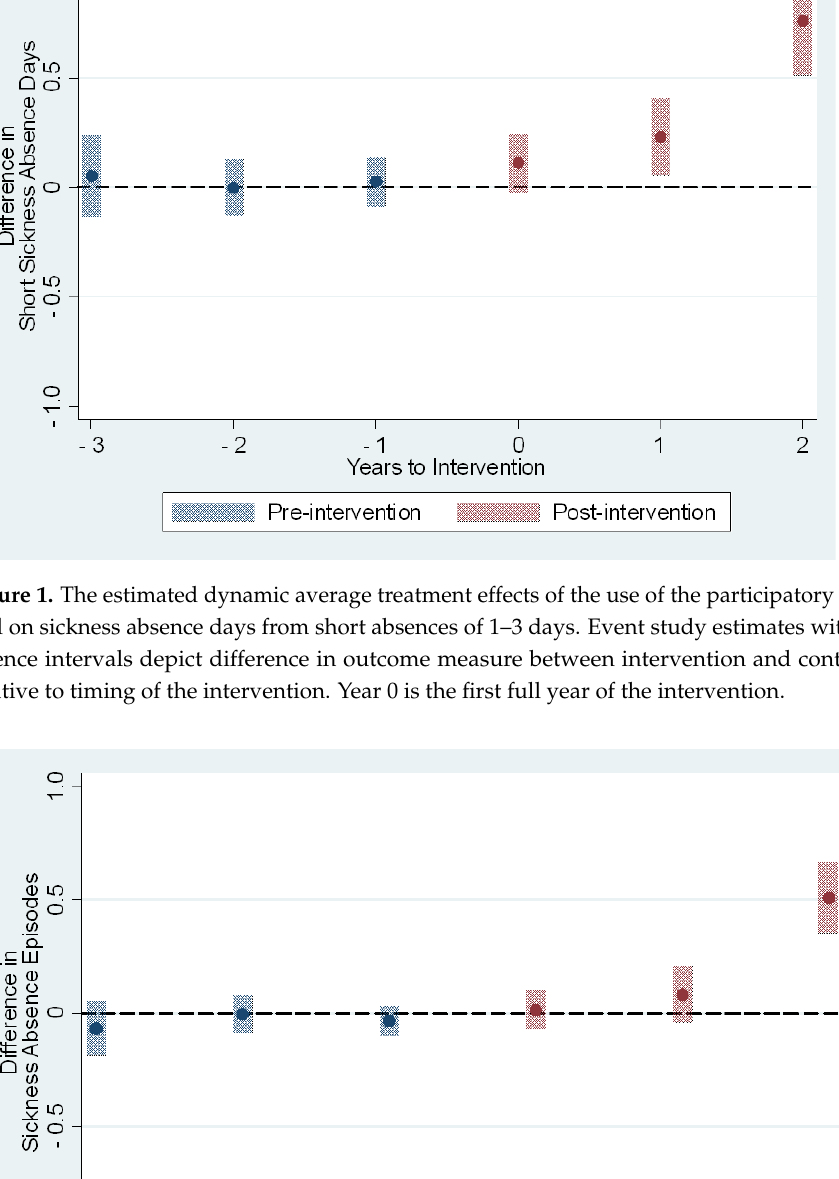
Figure 3. The estimated dynamic average treatment effects of the use of the participatory scheduling tool with shift schedule evaluation tool on sickness absence days from short sickness absences of 1– 3 days. Event study estimates with 95% confidence intervals depict difference in outcome measure between intervention and control groups relative to timing of the intervention. Year 0 is the first full year of the intervention.